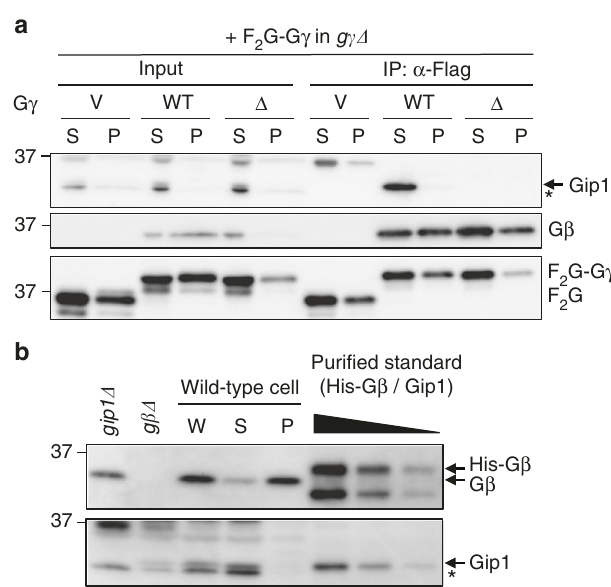
Fig. 4 Subcellular localization of endogenous Gip1 and G β . a Preferential complex formation between G proteins and Gip1. Cells were fractionated, and each fraction was used for the IP of F 2 G or F 2 G-tagged G γ . The indicated proteins were visualized by immunoblotting using anti-Gip1, G β , and Flag antibodies. b The amount of endogenous G β and Gip1. Cells were fractionated to obtain whole-cell extract (W), supernatant (S), and precipitant (P), and their containing proteins were estimated in comparison to puri fi ed protein standards. The bands indicated by arrows represent His- G β , G β , and Gip1. Bands with an asterisk denote nonspeci fi c